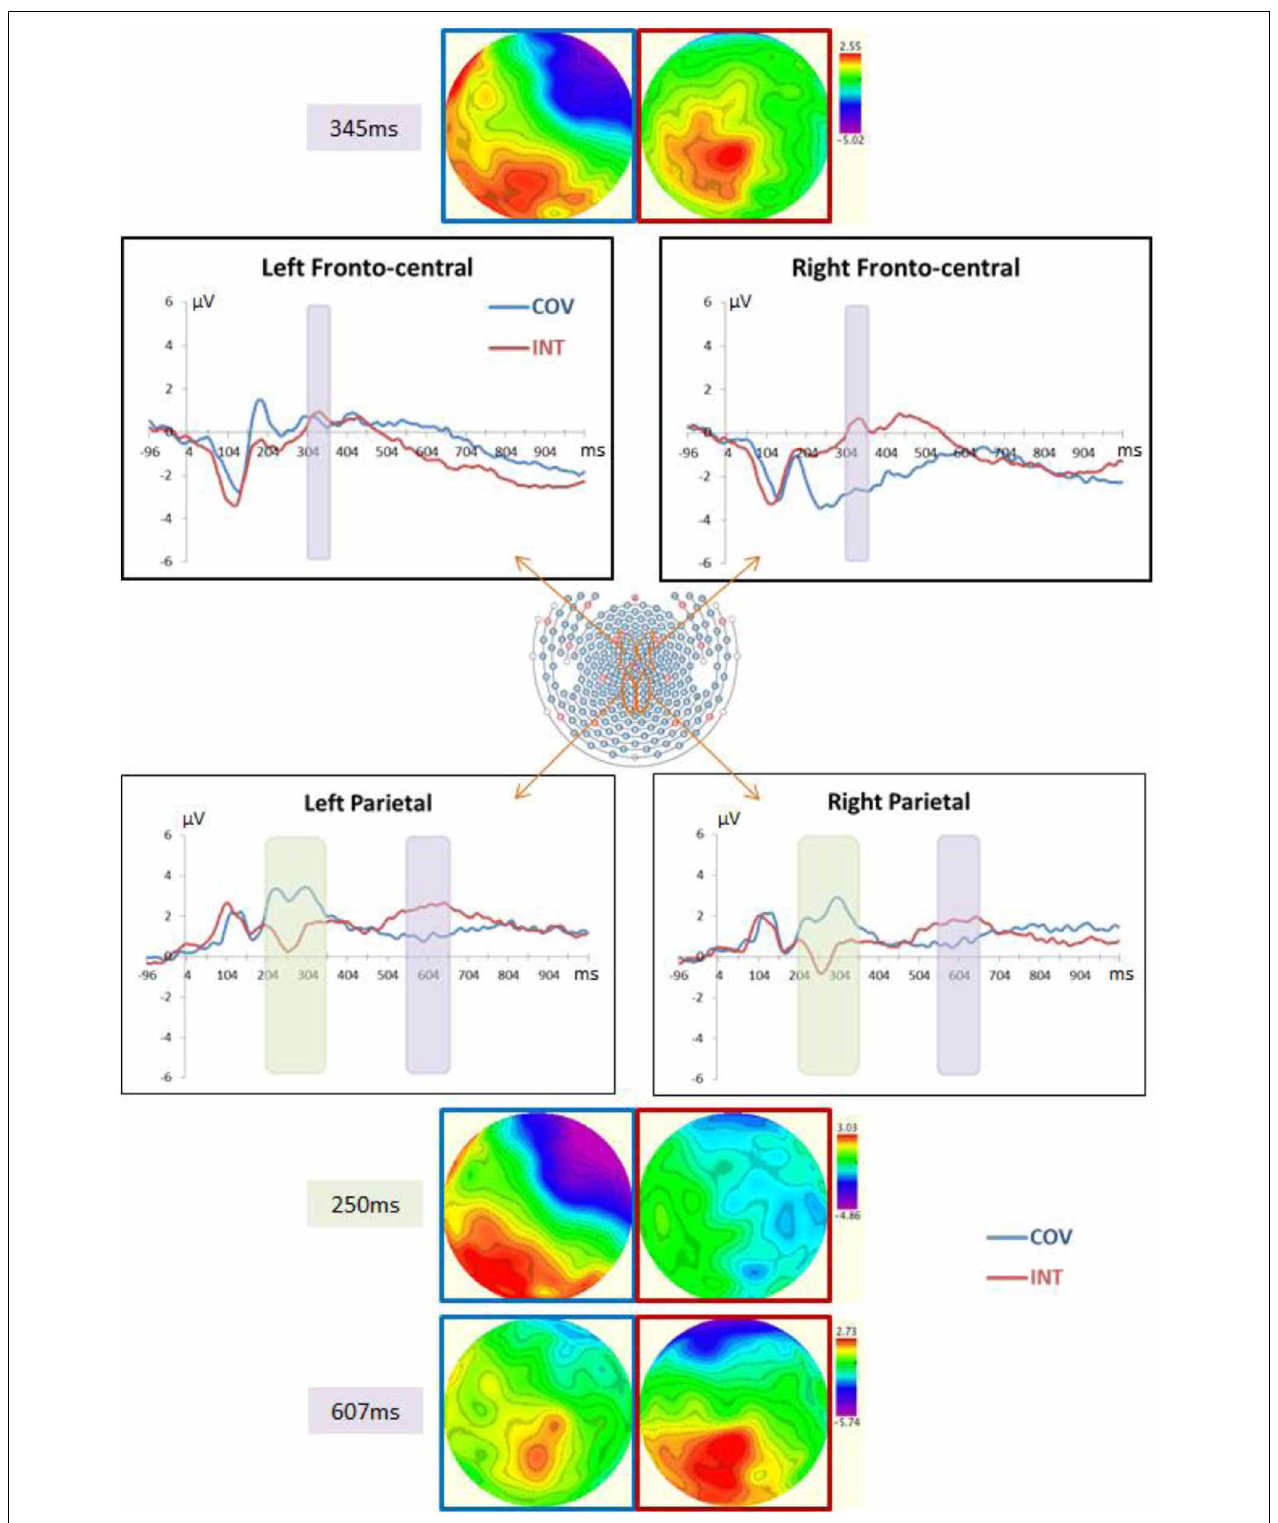
FIGURE 4 | Central panel: Depiction of the fronto- and parieto-central channel subsets used for the ERP analyses. ERP waveforms in this figure correspond to the average of each channel subset depicted in orange. Top left and right panels: ERPs at, respectively, the left and right fronto-central